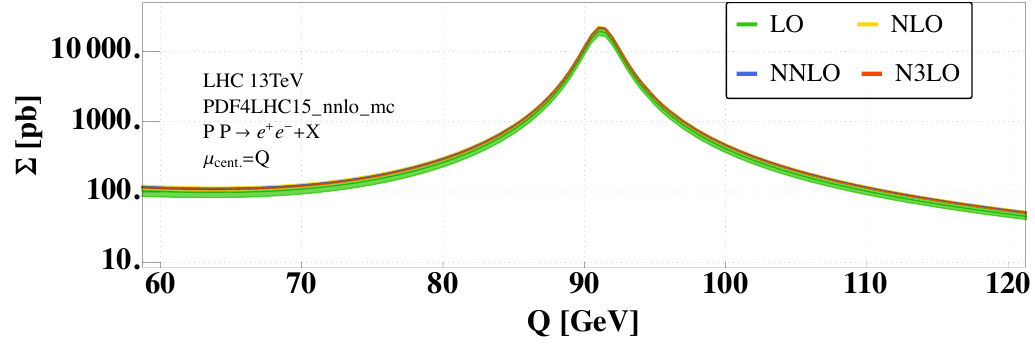
√ S = 13 TeV at different orders